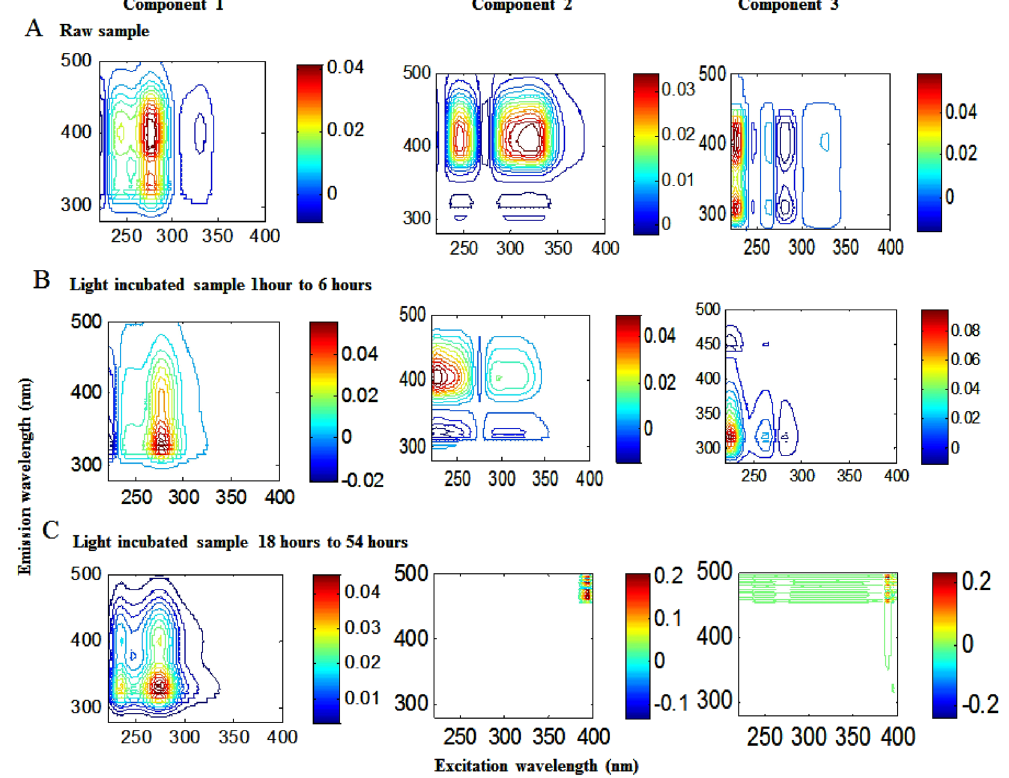
Figure 4. Fluorescent components of EEM-PARAFAC identified by three-component analysis for: ( A ) Raw EPS samples, ( B ) sunlight irradiated EPS sample from 1 hour to 6 hours and ( C ) sunlight irradiated EPS sample from 19 hours to 58 hours of exposure. Only daylight exposure hours (12 hours per day) were counted, to the exclusion of night hours.